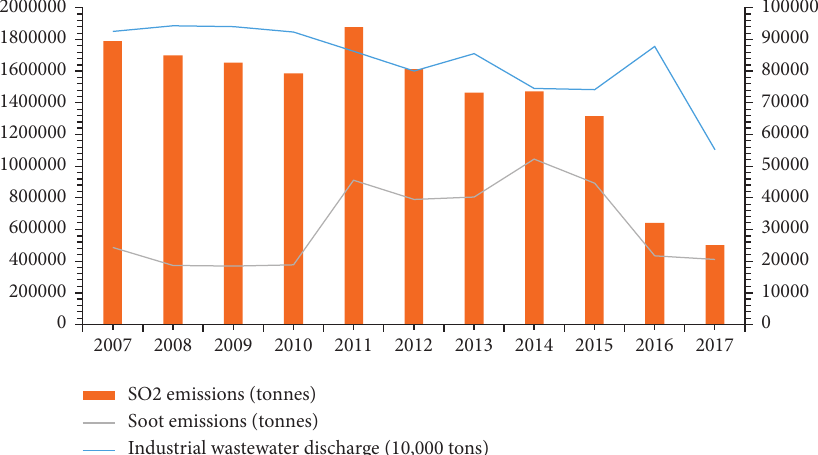
Figure 2: Unexpected output in prefecture-level